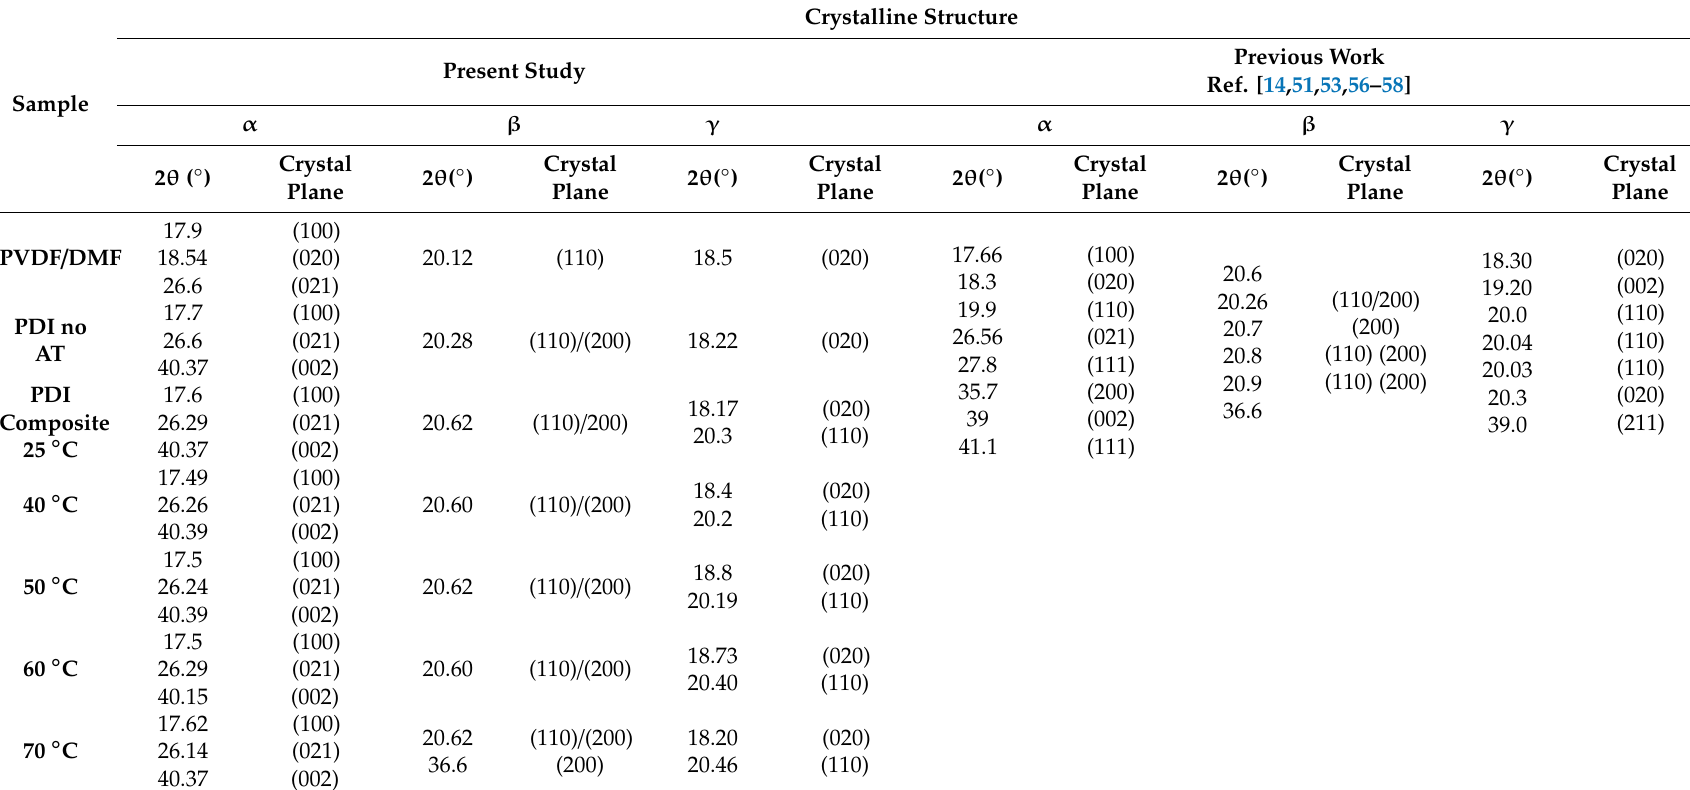
Table 2. Di ff raction crystal plane of PVDF / DMF and PDI composite